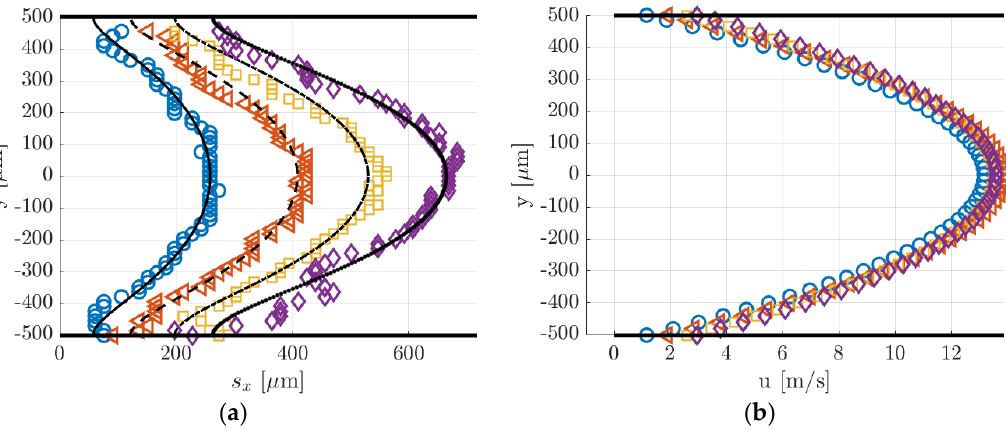
Figure 16. ( a ) Displacement data computed by applying the Gaussian fitting per line to the images of Figure 15. The black lines represent the numerical solutions for the displacement profile provided by the reconstruction method; ( b ) velocity reconstruction from the displacement data in ( a ): Δ𝑡 = 20 µs ( O ), 30 µs ( ), 40 µs ( ☐ ), and 50 µs ( ◇ ).